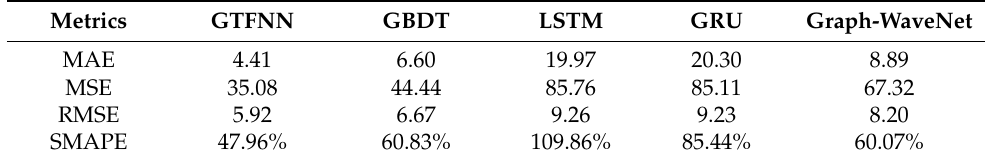
Table 8. The mean performances of models in forecasting holiday OD